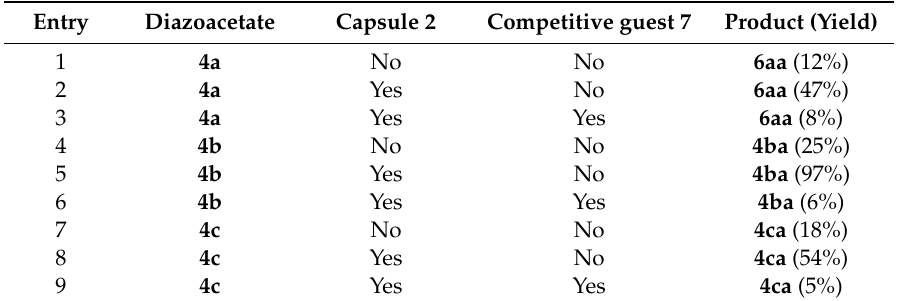
Table 1. Catalytic tests for the 1,3-dipolar cycloaddition of diazoacetate esters with acrolein mediated by capsule 2